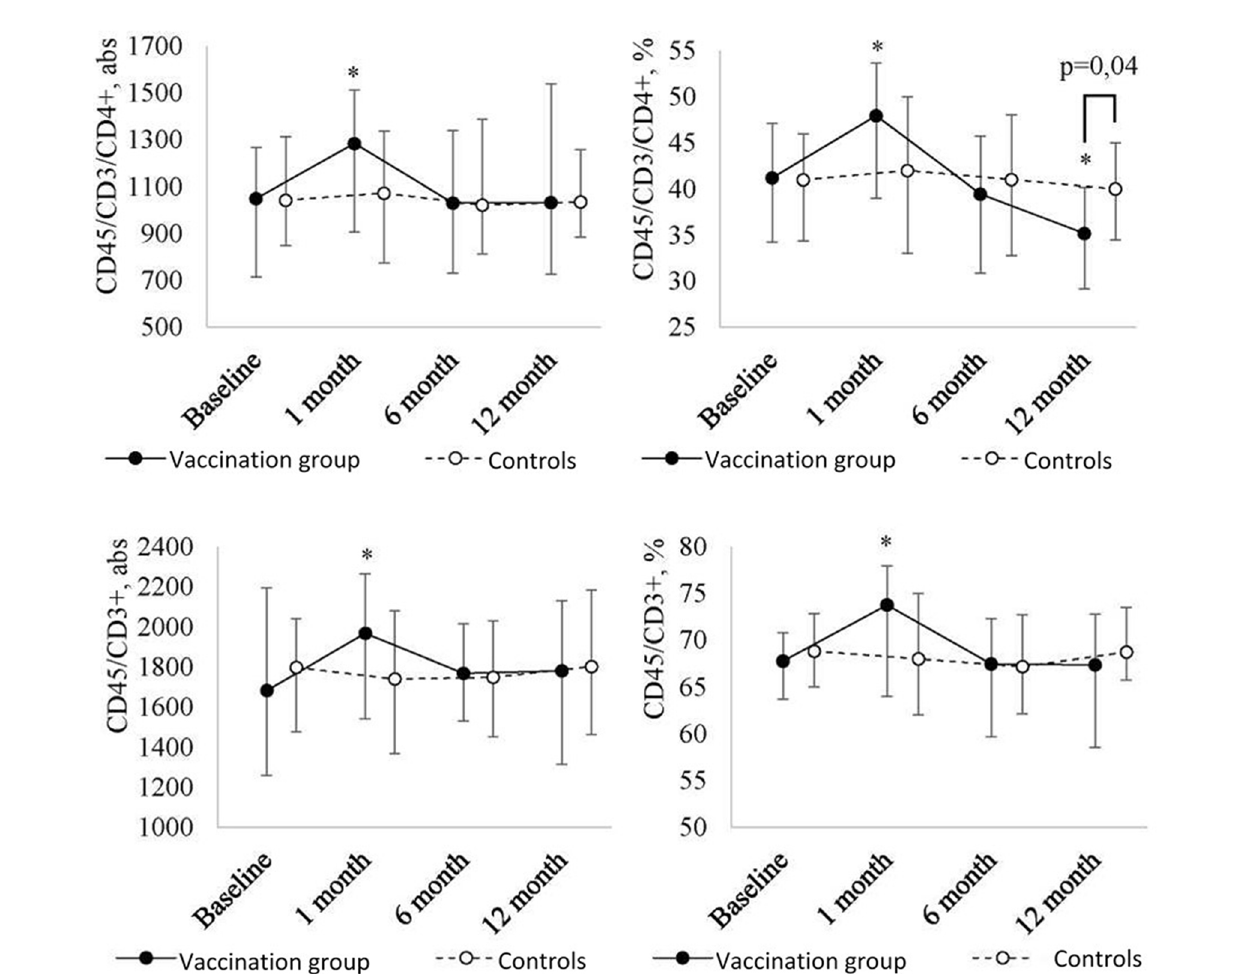
FIGURE 2B | Peripheral blood T lymphocyte (CD45/ С D3+, CD45/CD3/ С D4+) level dynamics in children with a history of solid tumors in the study group (after the revaccination with the ADS-m toxoid, n = 26) and the control group (n = 15), the median and the interquartile range are shown [Me (Q1-Q3)]. *statistically signi fi cantly different from the pre-vaccination value (p ≤ 0.05). To analyze alterations, the post-hoc Demsar test was used with a statistically signi fi cant Friedman omnibus test. Study groups were compared with the Mann-Whitney